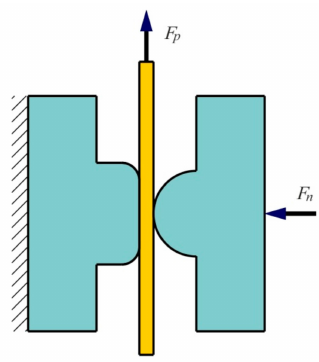
Figure 5. Strip-drawing test setup with combined shapes of counter-samples.